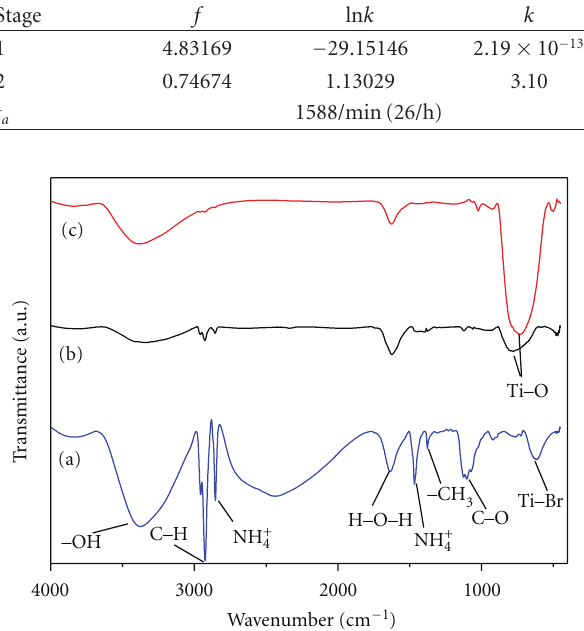
Table 3: Rate constant of crystal growth and chronological series.